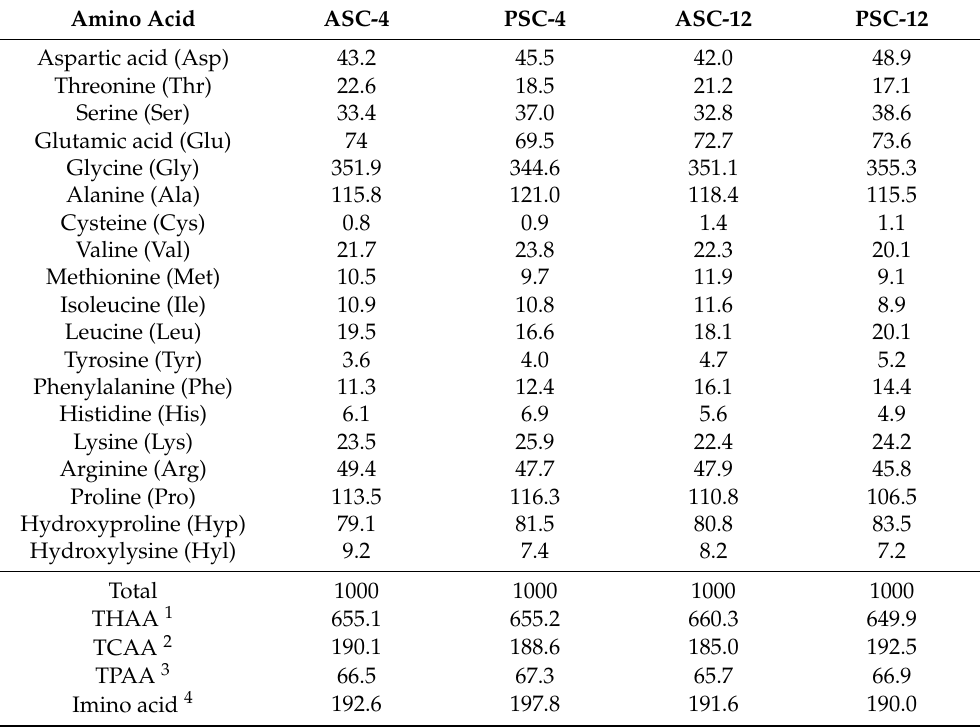
Table 1. Amino acid composition of ASC and PSC extracted at 4 and 12 ◦ C from the skin of pufferfish (residues/1000 residues). Amino Acid ASC-4 PSC-4 Aspartic acid